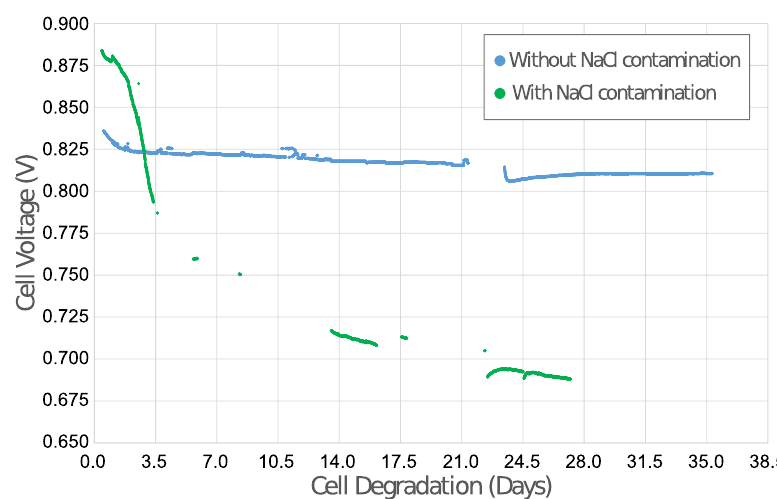
Figure 8. Long-term degradation of the single cell at 900 ◦ C and a current density of 285 mA/cm 2 without salt contamination and with 1 ppm of continuous salt contamination.